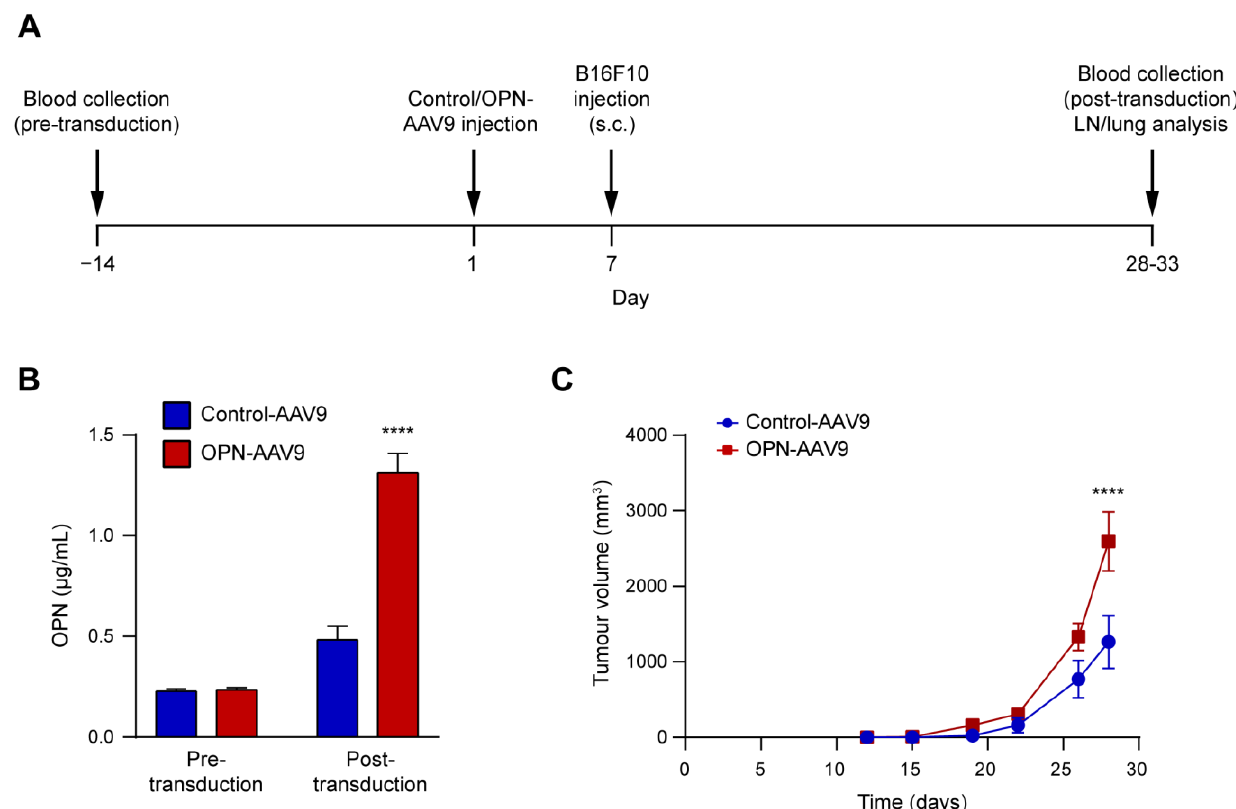
Figure 4. Increased cOPN levels promote melanoma growth. ( A ) Schematic illustration of the experimental time course. Mice were first injected i.v. with control-AAV9 and OPN-AAV9 at 5 × 10 10 viral particles per animal, and 6 days later they were transplanted with 1 × 10 5 B16F10 melanoma cells s.c. Tumour growth was monitored, and at the end of the experiment blood, lymph nodes and lungs were collected for analysis. Additionally, blood was collected 14 days before viral transduction to determine pre-transduction baseline levels of OPN. ( B ) Plasma OPN levels pre- and post-transduction were determined by ELISA. Control and OPN-AAV9 transduced animals were compared using Student’s t -test. ( C ) Tumour size following s.c. transplantation of B16F10 melanoma cells. Groups were compared using repeated measures two-way ANOVA with Šídák’s multiple comparisons tests; n = 6 for Control-AAV9 and n = 7 for OPN-AAV9. **** p < 0.0001.